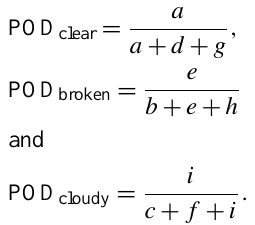
Figure 1. Density plot of the occurrences of the CFC by HSI as a function of instantaneous CFC in oktas by SEVIRI. Each color of one box represents the amount of matches at the respective CFCs by HSI and SEVIRI. The total of all valid matches is 957 and rep- resents the results from 1 July to 30 September 2009 for